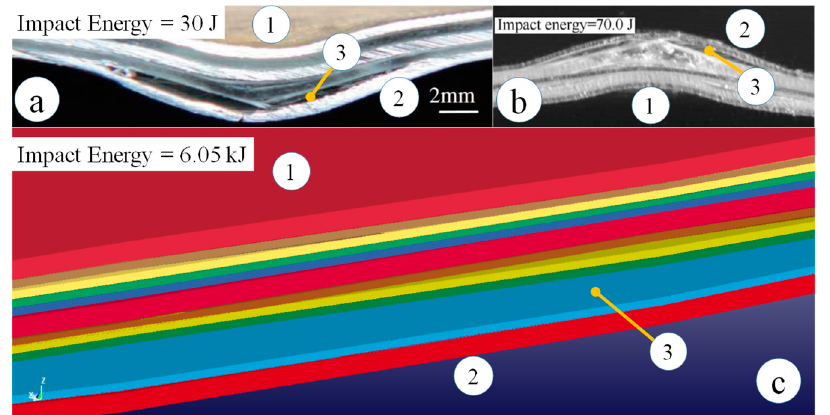
Figure 6. Delamination failure of GLARE laminates determined by ( a ) Yaghoubi et al. [64], ( b ) Chen et al. [71], and ( c ) numerical analysis of this study; 1 and 2 stand for the impacted side and the non-impacted side, respectively; 3 stands for the GF/EP-90°/0° interface delamination at room temperature.